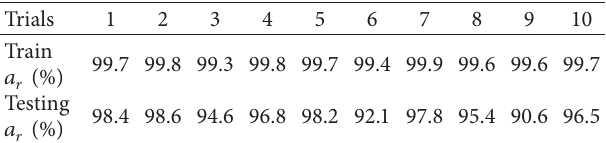
Table 4: Results of 10 trials of the proposed